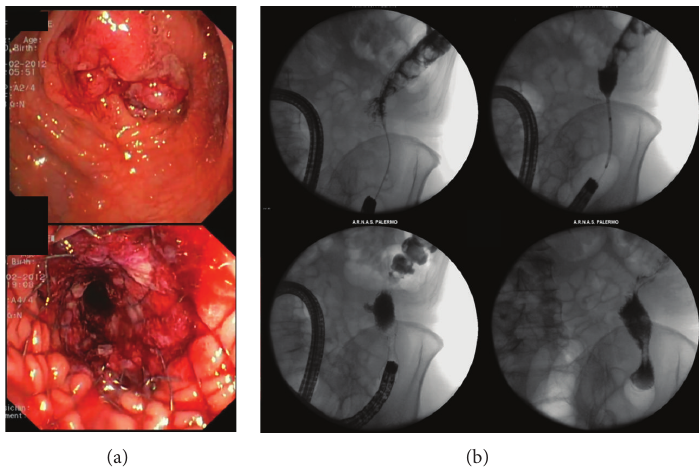
Figure 1: Procedure for a nitinol SEMS placement in a 78-year-old man admitted because of intestinal occlusion due to colorectal cancer of the descending colon (a). The patient’s symptoms improved early after stent placement